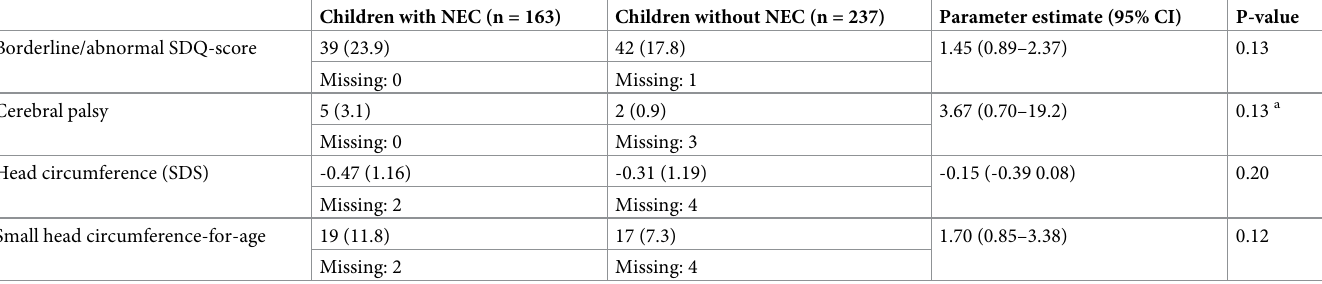
Table 4. Occurrence of primary and secondary outcome and their association with NEC in univariable